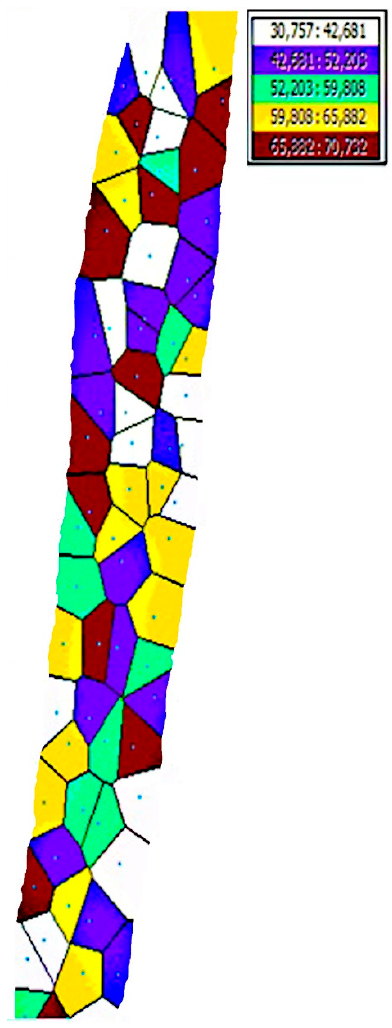
Figure 11. Voronoi map of the study.